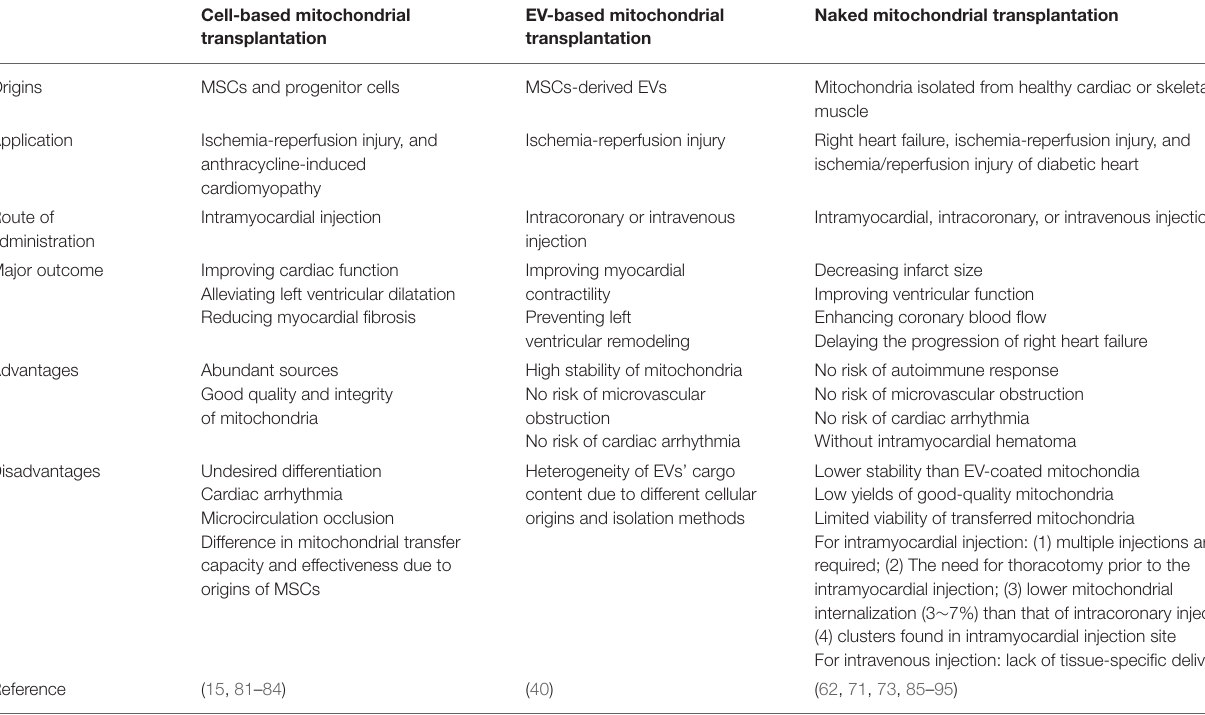
TABLE 4 | Summary of mitochondrial transfer strategies for cardiovascular